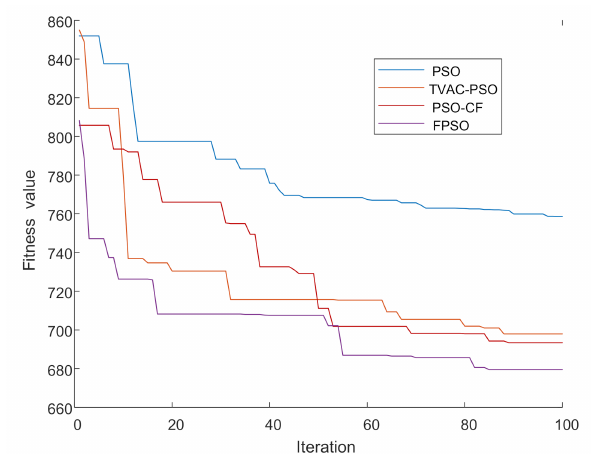
Figure 14. The convergence characteristics of PSO, time variable acceleration coe ffi cient with PSO (TVAC-PSO), PSO with constriction factor (PSO-CF), and FPSO in Case